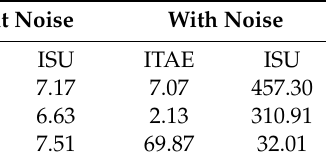
Table 1. Performance indices.